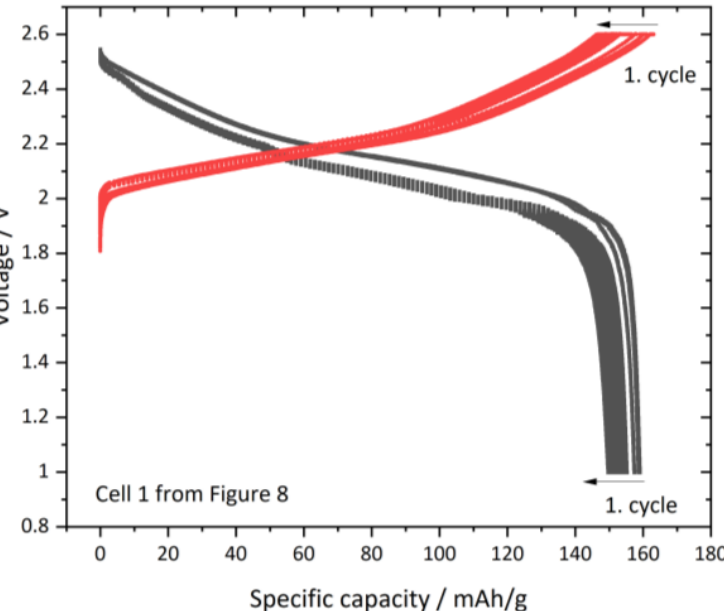
PCPIS at at 45 °C; ( Right ): coulomb efficiency of tested cells shown on the left.